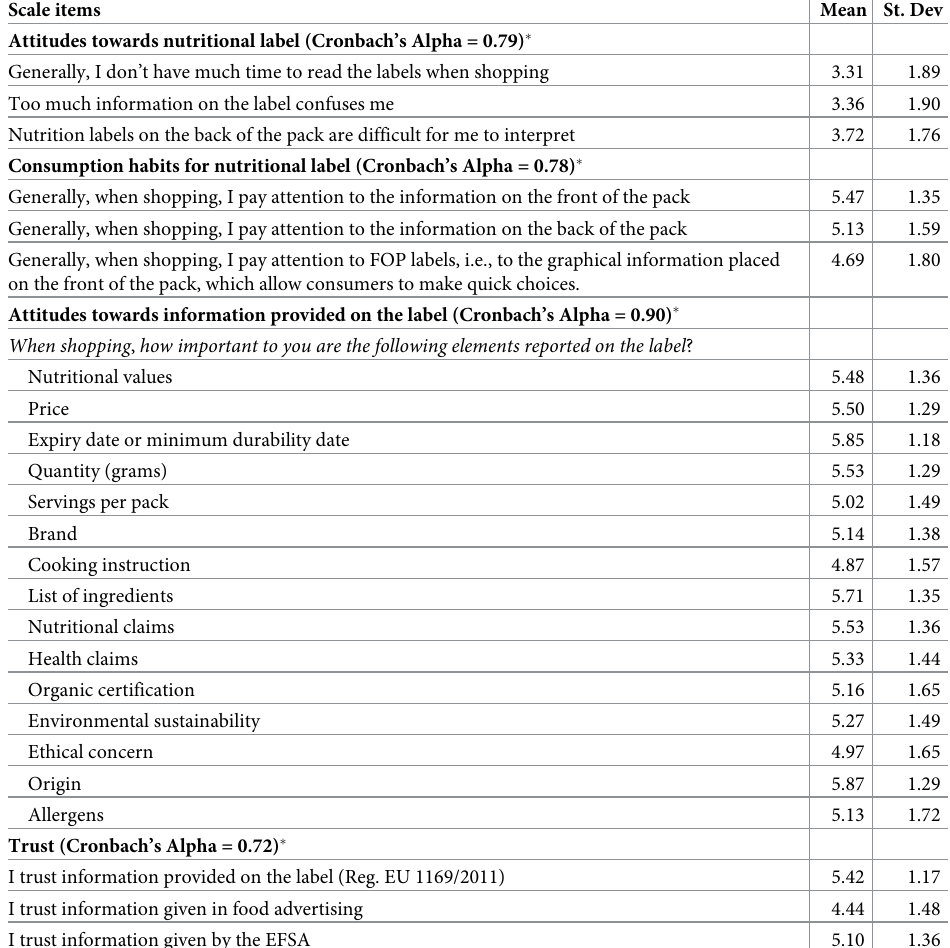
Table 4. Likert scale measuring consumers’ shopping habits for nutritional labelling. Scale items Mean St. Dev Attitudes towards nutritional label (Cronbach’s Alpha = 0.79) � Generally, I don’t have much time to read the labels when shopping 3.31 1.89 Too much information on the label confuses me 1.90 Consumption habits for nutritional label (Cronbach’s Alpha = 0.78)